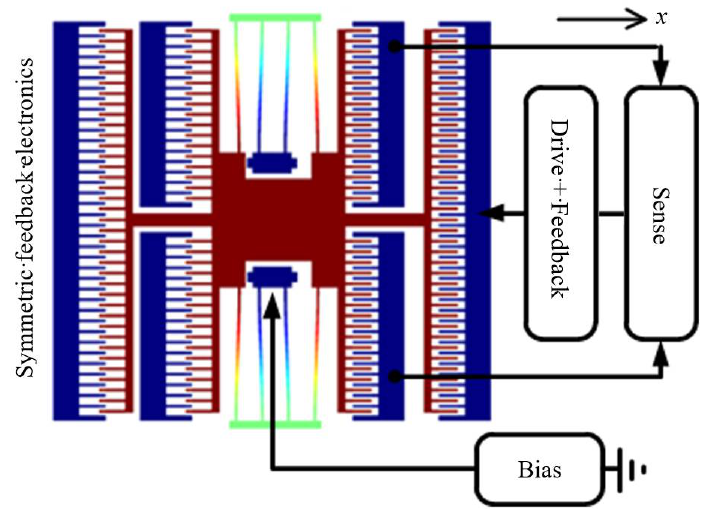
Figure 2. MEMS + performance controller [29]. Symmetric feedback components on the right and left (not shown) sides of the structure operate 180° out of phase for continuous feedback response throughout each cycle. Feedback forces are applied to left and right combs according to position, velocity, and acceleration.